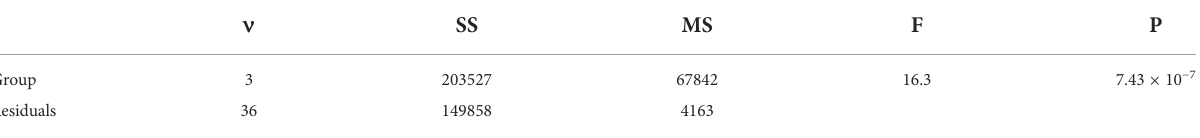
TABLE 9 Results of ANOVA of TNF- a